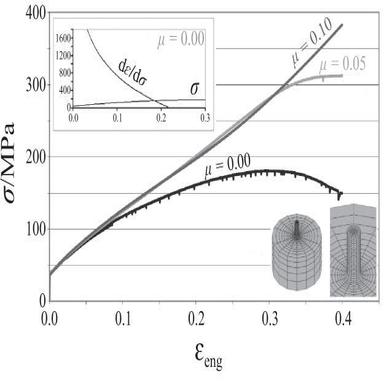
Results of the Copper pillar compression simulation: Engineering stress-strain curves (bottom) for the three cases with different friction coefficients ( : stress, d /d : hardening). Figure adopted from with permission from Elsevier.